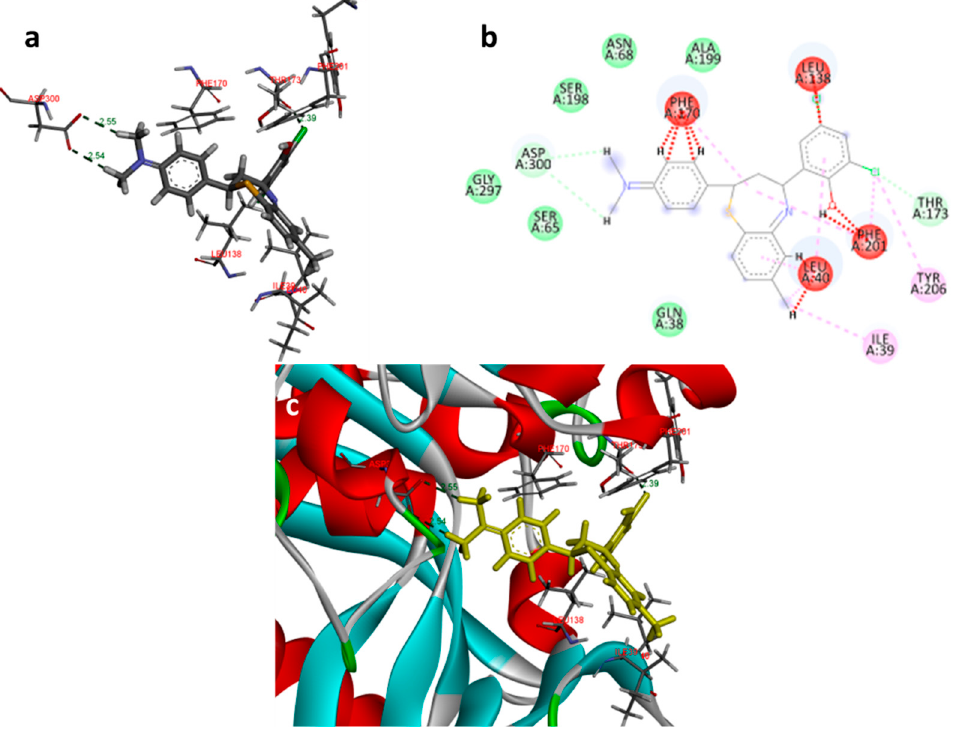
Figure 6. Docking images of compound 2c on 2I6B: ( a ) H-bonds between 2c and protein residues; ( b ) 2d representation of interactions in binding cavity; ( c ) 3D representation of interactions in the binding